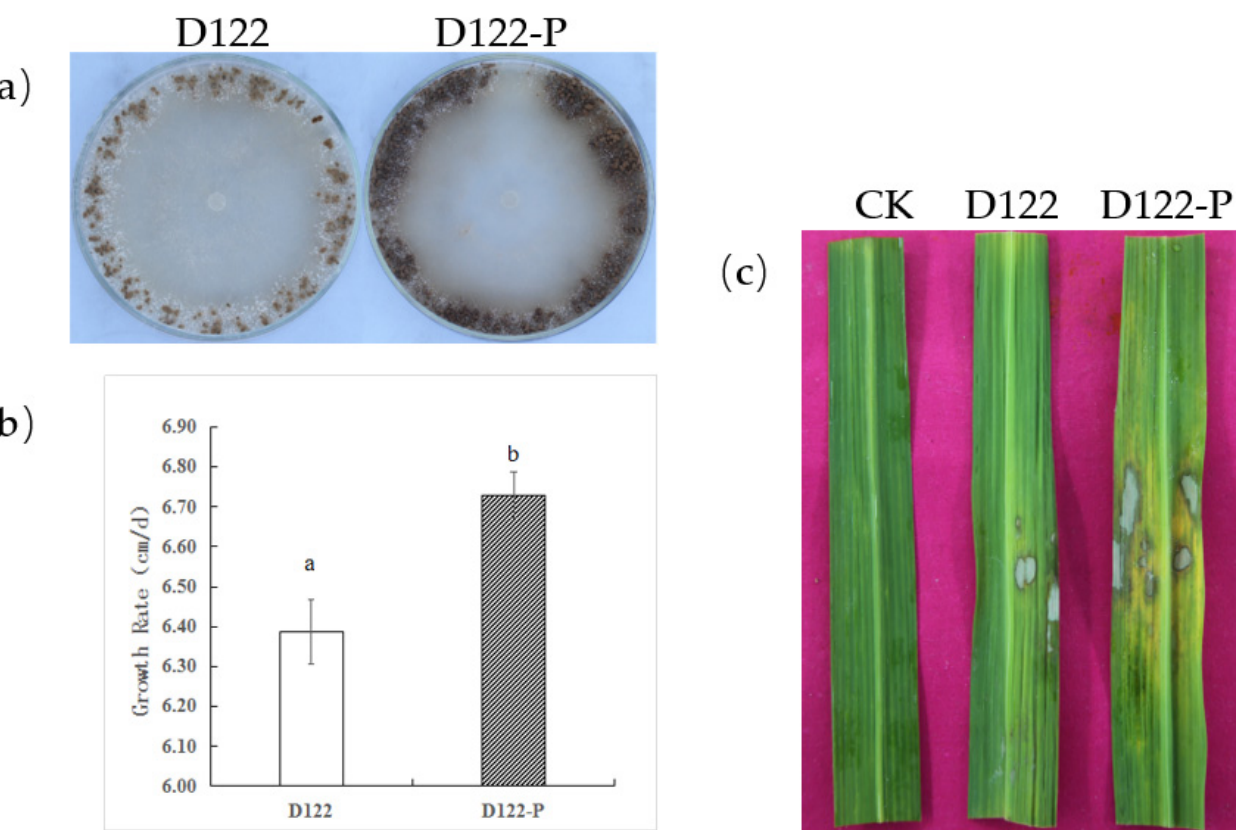
Figure 6. Hypovirulence-associated traits in strain D122 of Rhizoctonai solani AG-1 IA. ( a ) Colony morphology of strains D122 and D122-P after 4 days of culture on PDA in the dark; ( b ) comparison of average mycelial growth rate on PDA plates of the strains D122 and D122-P. The lowercase letters (a and b) on top of the bars in b indicate whether the differences are statistically significant ( p < 0.05); ( c ) Pathogenicity. The symptoms on detached rice leaves caused by strains D122 and D122-P at 28 °C for 72 h.